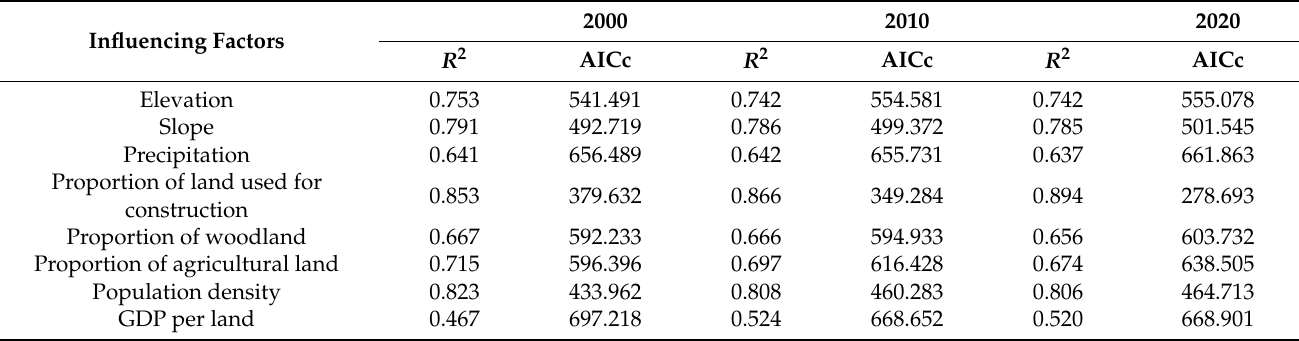
Table 7. Geographically weighted regression (GWR) model